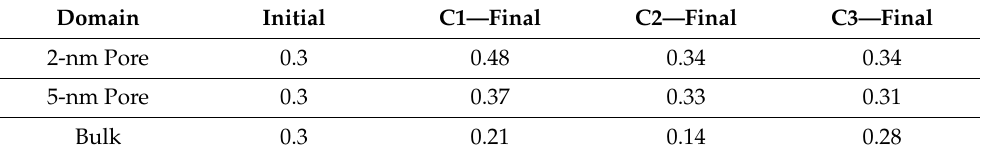
Table 2. Initial and final heptane mass fraction in 2-nm and 5-nm pores and bulk mediums. Domain